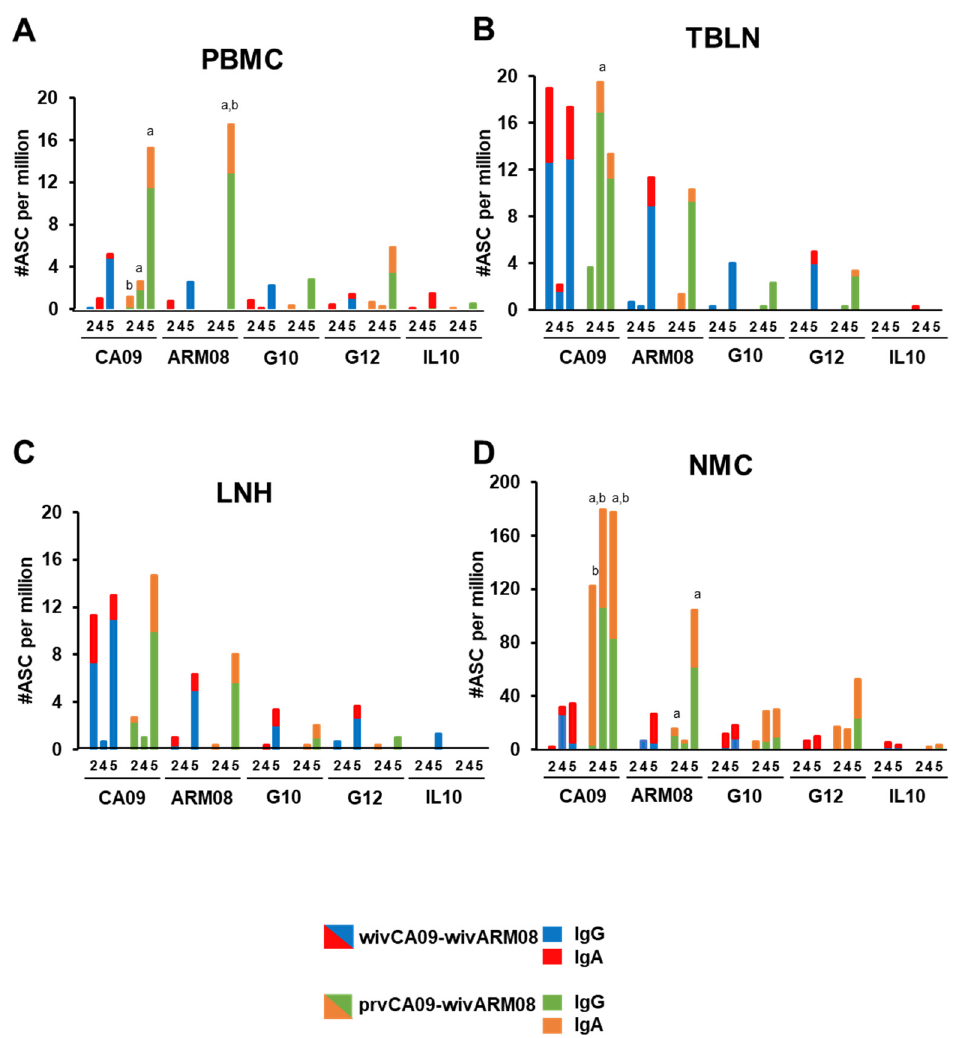
Figure 5. Mean numbers (#) of virus-specific IgG and IgA antibody-secreting cells (ASCs) against vaccine and challenge viruses determined by ELISPOT in peripheral blood mononuclear cells (PBMC) ( A ), tracheobronchial lymph nodes (TBLN) ( B ), lymph nodes of the head (LNH) ( C ) and nasal mucosa (NMC) ( D ) after wivCA09–wivARM08 vaccination (blue and red) or prvCA09–wivARM08 vaccination (green and orange). Responses were examined 2 and 4 weeks post-vaccination 1, and 1 week post-vaccination 2 (weeks 2, 4, and 5). Mock-vaccinated control pigs tested negative in all assays and are not shown. Letters indicate significant higher numbers of virus-specific IgG (a) or IgA (b) ASCs in group prvCA09–wivARM08 compared to group wivCA09–wivARM08 in the Mann–Whitney U test ( p ≤ 0.1).